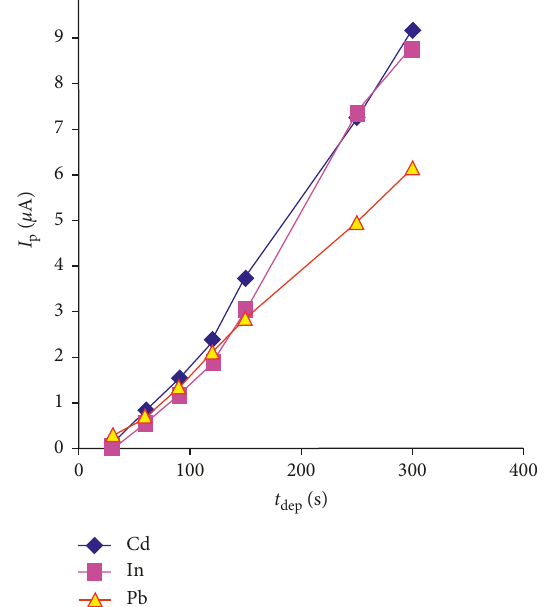
Figure 3: DP-ASV of Cd, In, and Pb at different t supporting electrolyte mixture of 0.1M KI and acetate